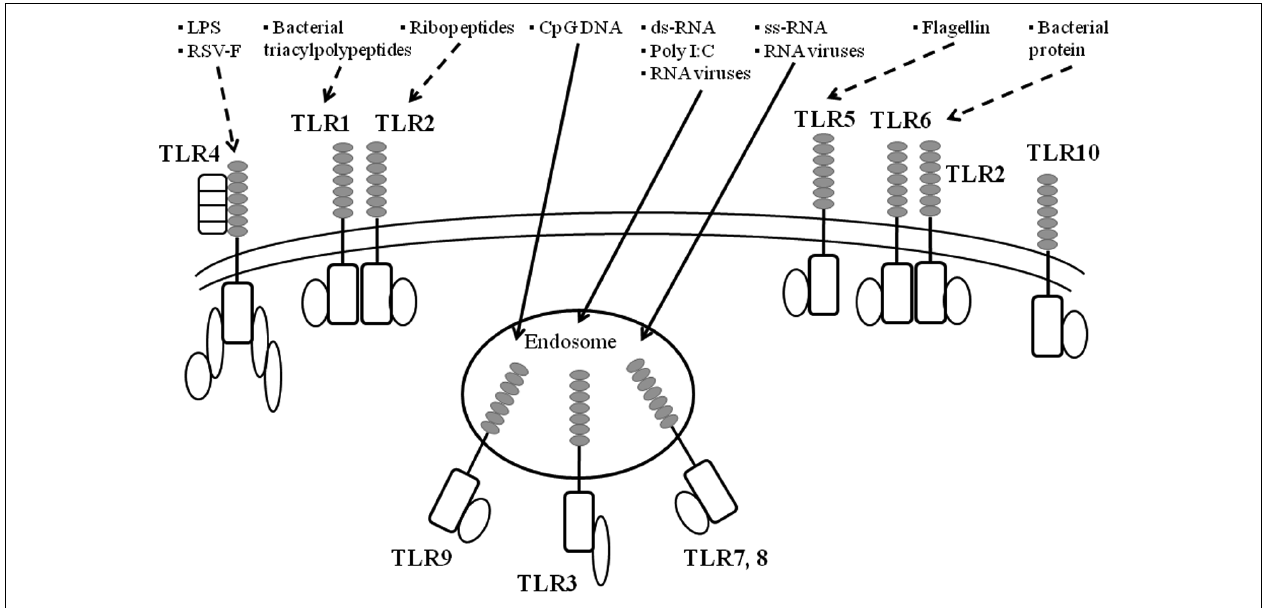
respectively, from mycobacteria.TLR5 responds to flagellin from the flagella of multiple bacteria.TLR7 andTLR8 detect single-stranded RNA (ss-RNA) from viruses, andTLR9 detects CpG DNA, which is common in bacterial and viral pathogens.TLR3 recognizes double-stranded RNA (ds-RNA) or synthetic compounds such as Poly